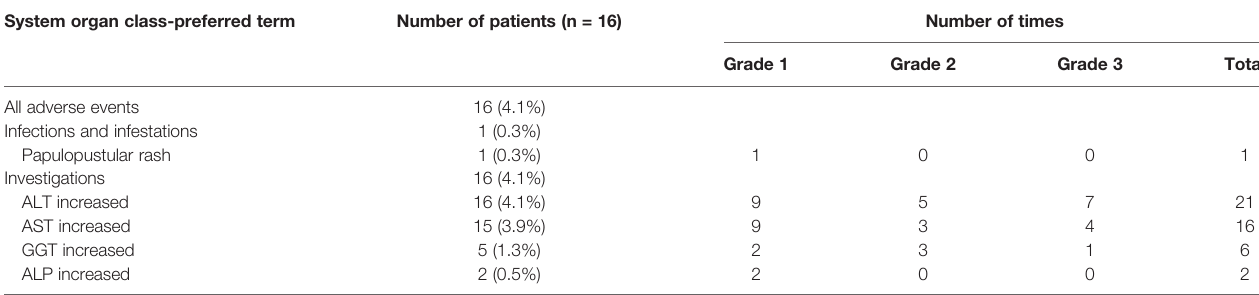
TABLE 2 | Patients experiencing adverse events that possibly related to study drugs. System organ class-preferred